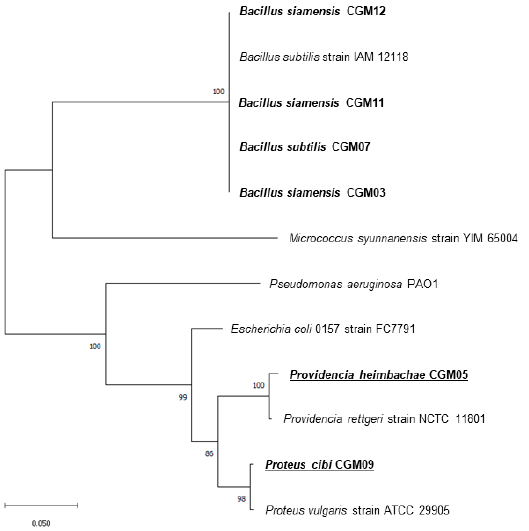
Figure 5. Phylogenetic positions of the isolates and their close relatives. The tree was constructed by using the neighbor-joining method. Scale bar indicates 0.05 substitutions per nucleotide position.